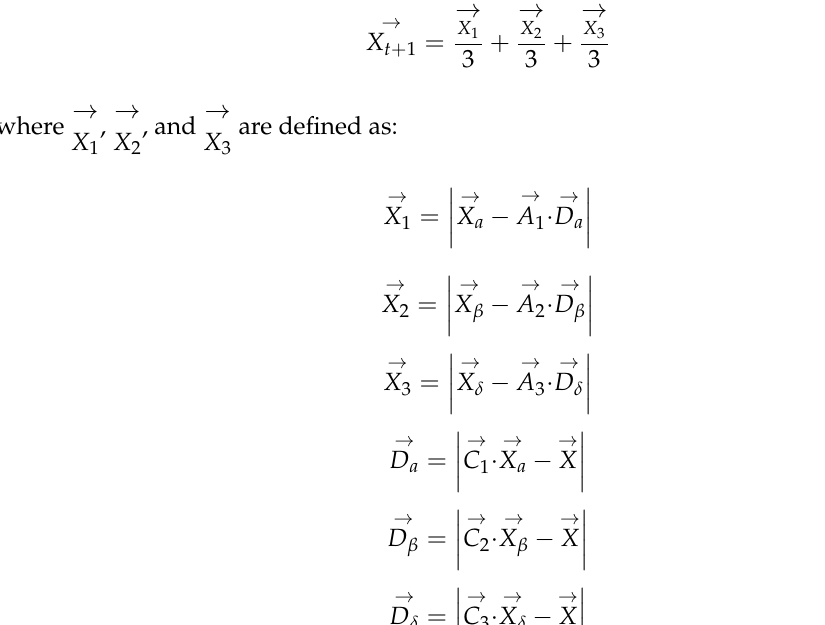
Figure 7. Updating the Grey wolf’s position. The three best locations for the wolves are used to determine the new locations for the wolves, as shown in equations below